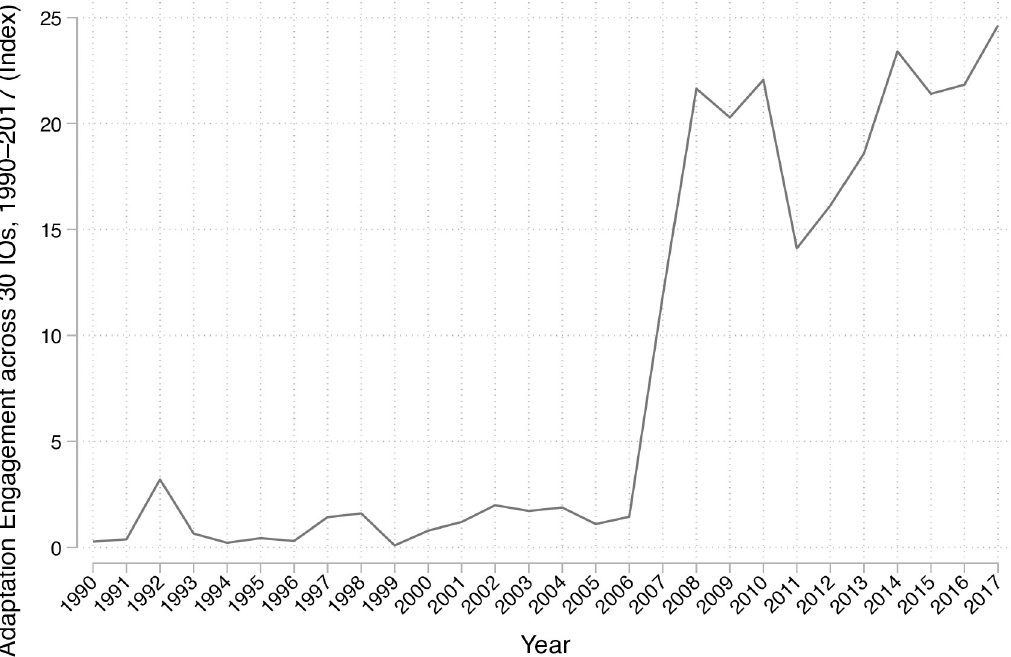
Fig 1. IO Engagement Index across 30 IOs, yearly